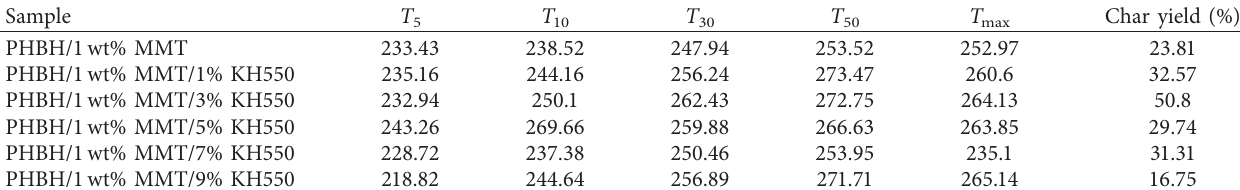
Table 3: Thermal weight loss data of PHBH/MMT/KH550 nanocomposites with different proportions of KH550. Sample T